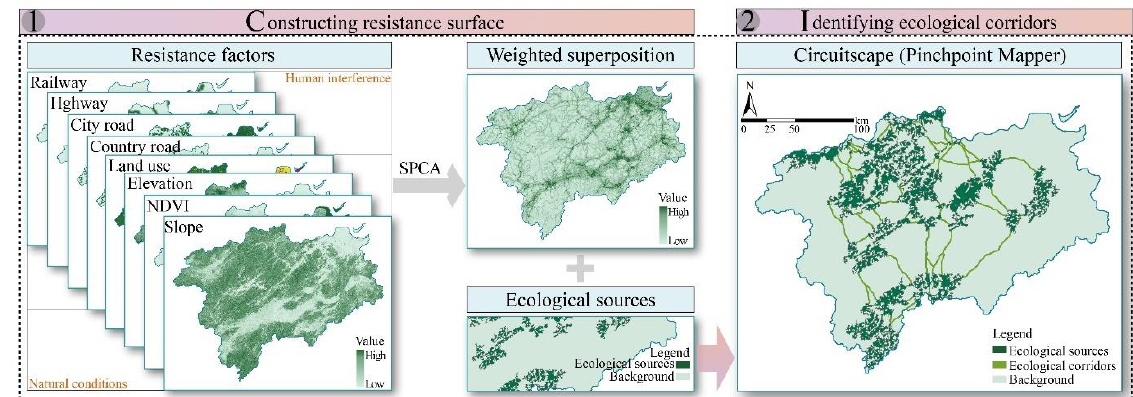
Figure 4. The construction of resistance surface and the extraction of ecological corridor.